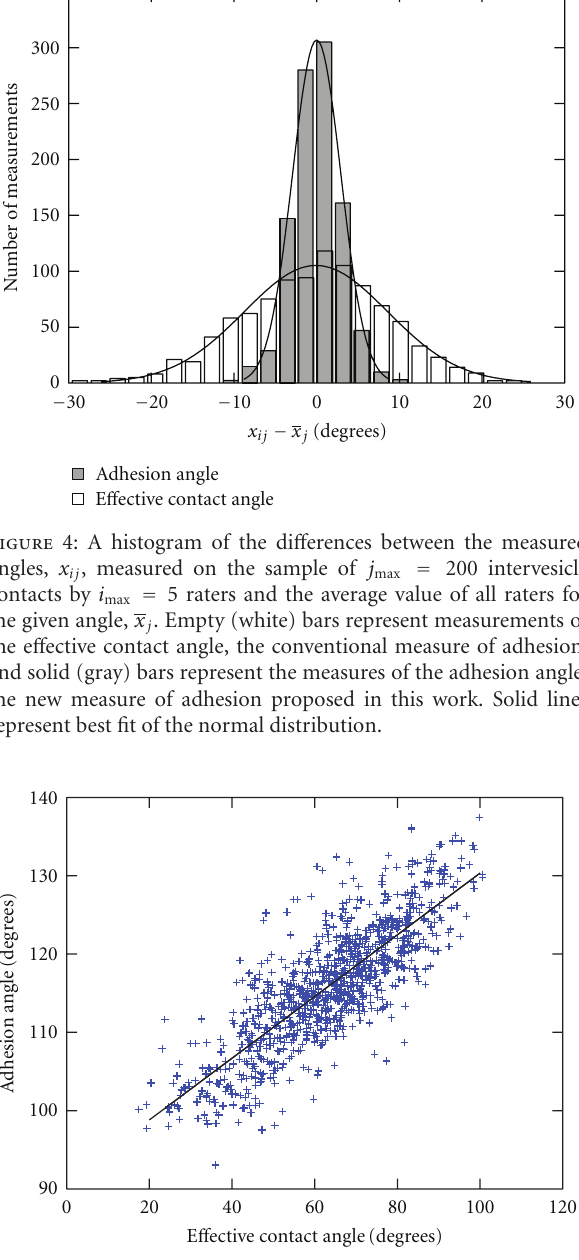
Figure 5: Correlation between the measured values of the e ff ective contact angle (conventional method for measuring adhesion) and the adhesion angle (here proposed measure of